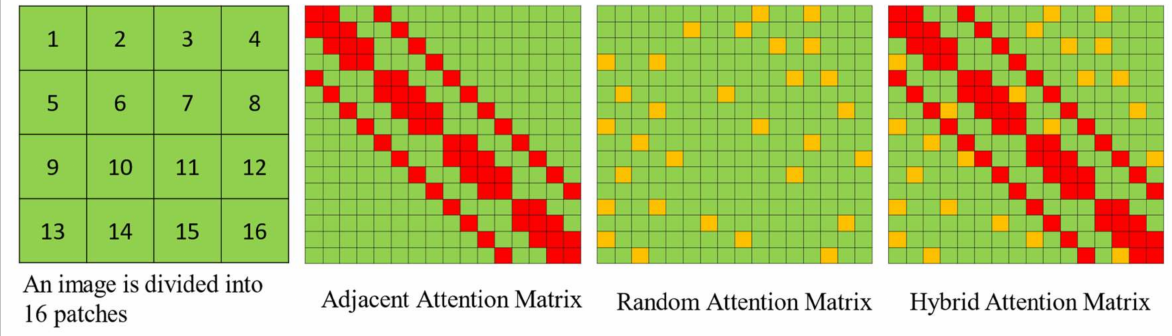
Figure 5. Illustration of the designed hybrid attention matrix composed of adjacent and random attention. In the attention matrix, green means not considered, red means considered by adjacent attention, and yellow means considered by random